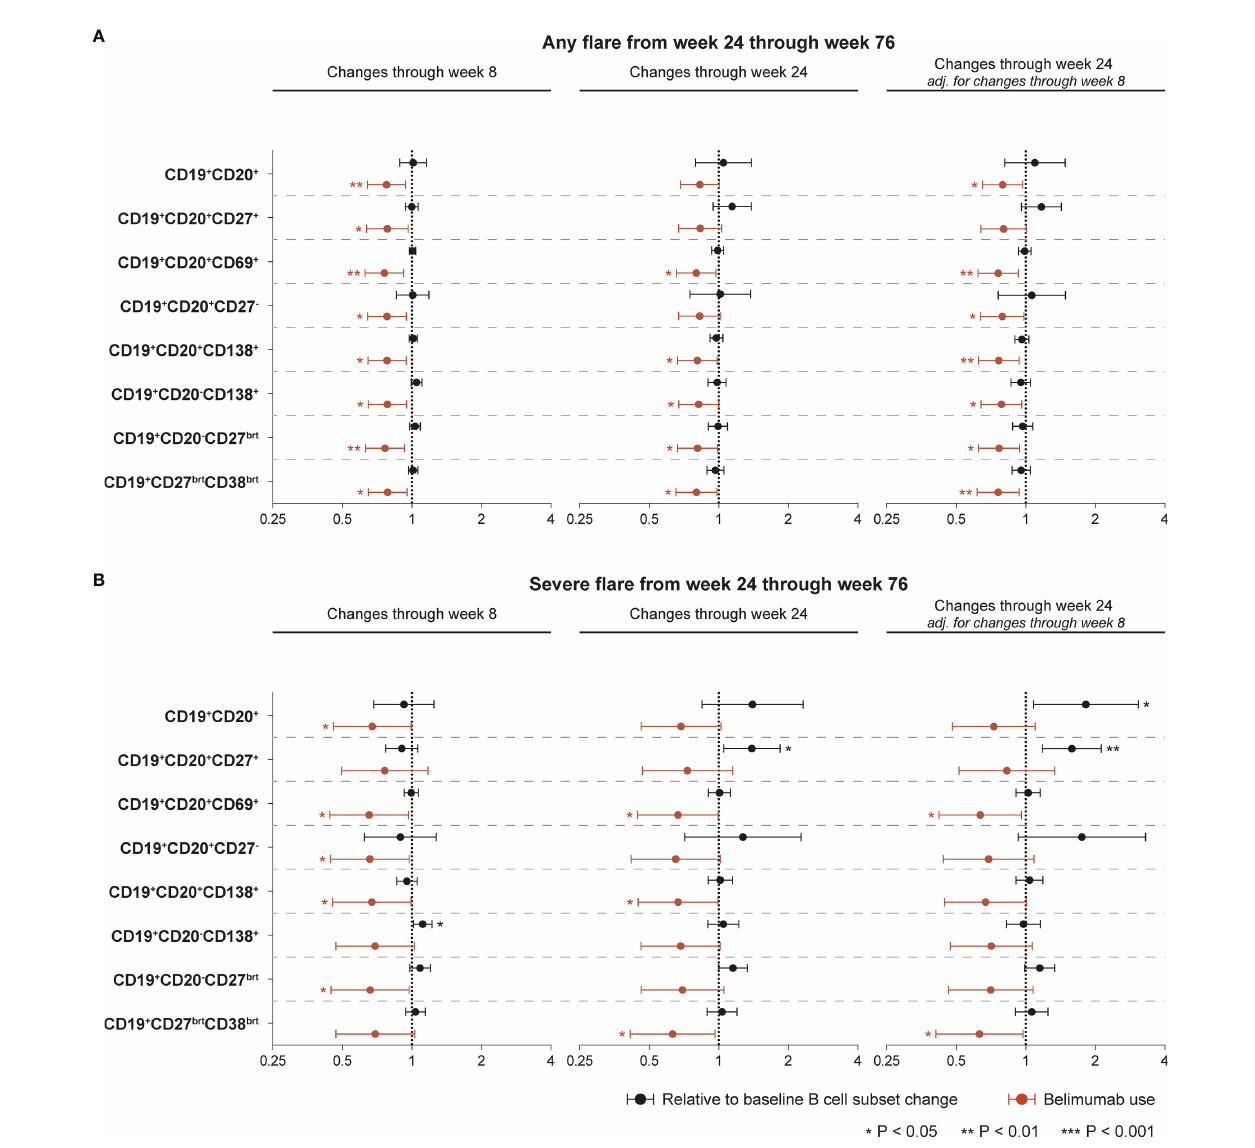
FIGURE 5 | Associations between B cell alterations and fl are development. The forest plots illustrate results from proportional hazards (Cox) regression analysis, investigating associations between rapid or early relative to baseline percentage changes in selected B cell and plasma cell subsets and development of the fi rst SFI fl are of any severity (mild/moderate or severe; (A) or the fi rst severe SFI fl are (B) occurring from week 24 through week 76 or the last available follow-up visit. All models included belimumab use (any dose) as a covariate, and the result for the respective model is plotted in terracotta colour. The potential interaction between cell alterations and belimumab use were accounted for. Additionally, all models were adjusted for age, sex, ethnicity, SLE disease duration, use of methotrexate, use of azathioprine, use of mycophenolate mofetil, use of immunosuppressants other than those mentioned before, and the BLISS study to account for batch variations in cell analyses. One set of models investigating associations between early B cell changes and fl are development was also adjusted for the relative to baseline cell alterations from baseline through week 8 to account for alterations in opposing directions in the rapid and early follow-up phase. Circles denote hazard ratios and whiskers denote 95% con fi dence intervals. Statistically signi fi cant associations are indicated with asterisks. SFI, Safety of Estrogens in Lupus Erythematosus National Assessment (SELENA) - Systemic Lupus Erythematosus Disease Activity Index (SLEDAI) Flare